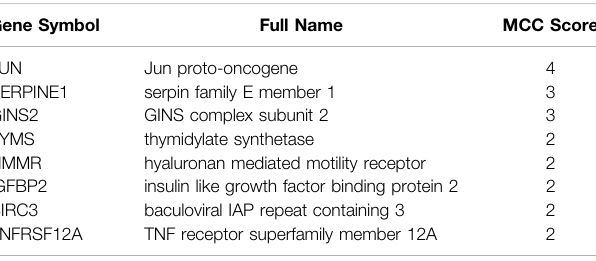
TABLE 3 | Top 8 hub genes based on MCC score.